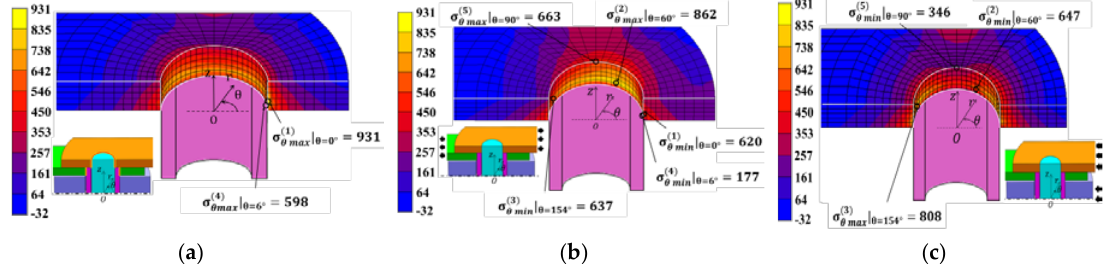
σ for the inner plate [MPa]: ( a ) press-fitting state; ( b ) tensile state; ( c ) Figure 7. Stress distribution σ θ for the inner plate [MPa]: ( a ) press-fitting state; ( b ) tensile state; Figure 8. Stress distribution θ ( c ) engaging state. engaging state.